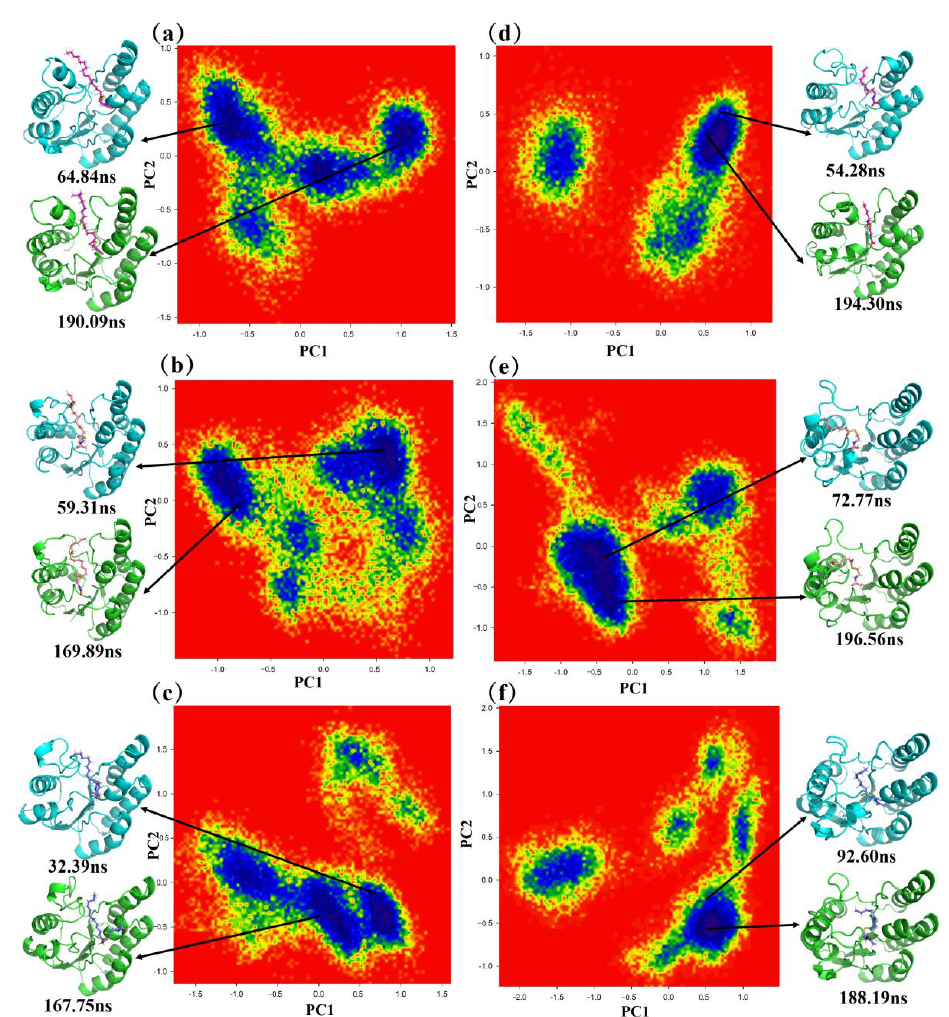
Figure 5. Free–energy landscape analysis of the six complexes and two representative con- formations in the MD simulation trajectories. The purple region has the lowest energy, and the red region has the highest energy. ( a ) ‘TesA_C16-SNAC, ( b ) ‘TesA E142D/Y145G